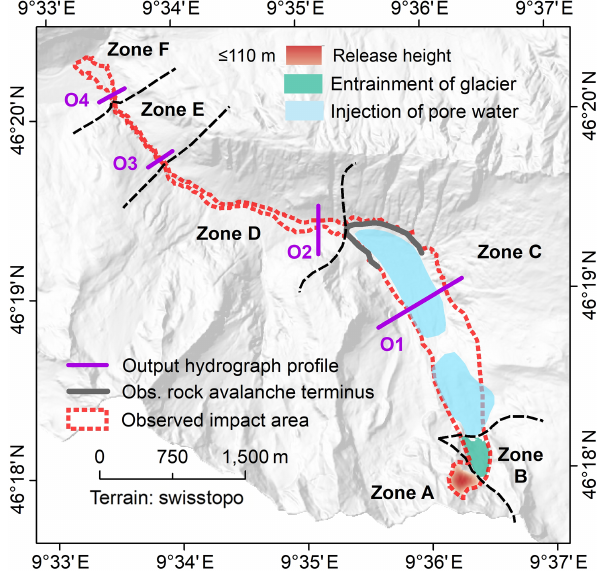
Figure 8. Maximum flow height and entrainment derived for Sce- nario S1. RA is rock avalanche; the observed RA terminus was de- rived from WSL